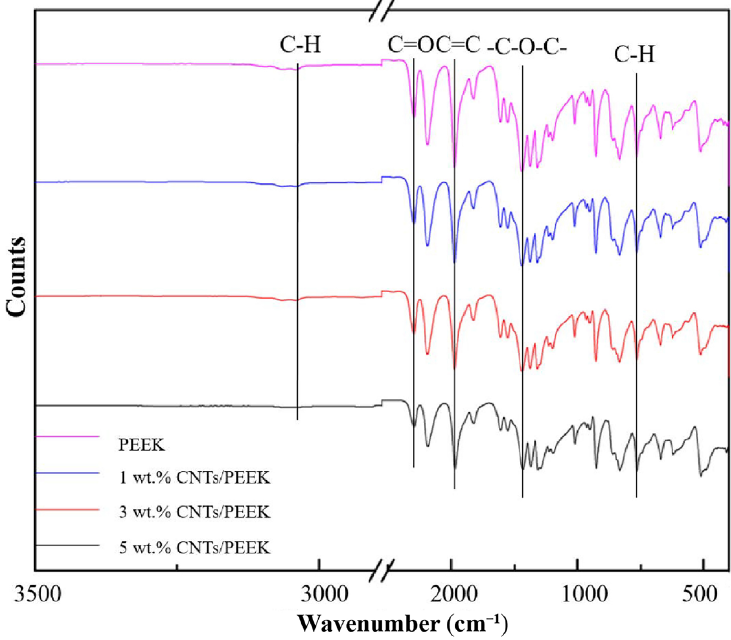
Figure 3. FT-IR of CNTs/PEEK composites. Coatings 2022 , 12 , x FOR PEER REVIEW